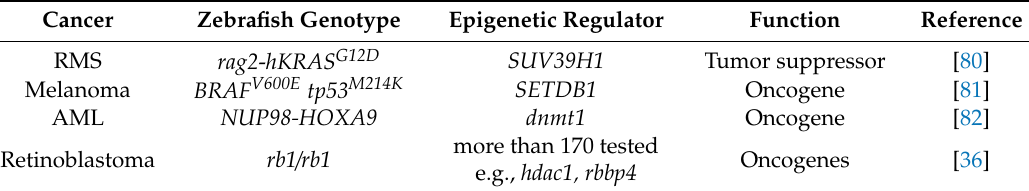
Table 2. Epigenetic regulators in zebrafish